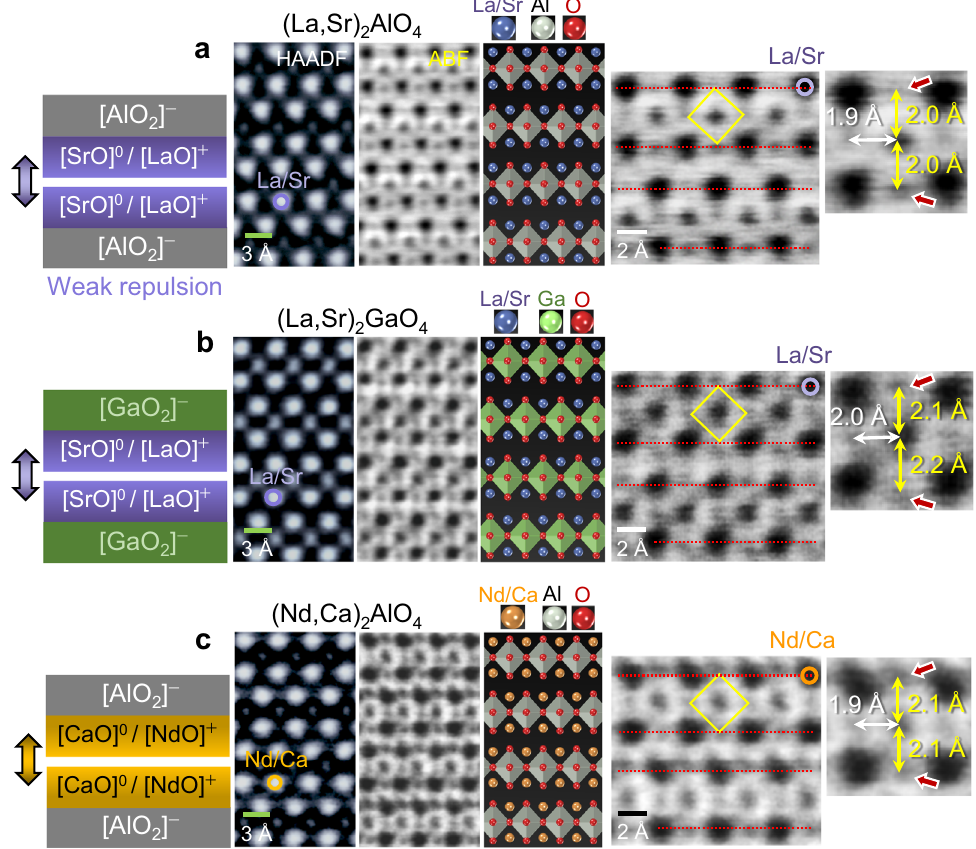
Fig. 8 STEM images showing the structure of (A ′ A ″ ) 2 BO 4 -type RP oxides. Atomic-column-resolved images were acquired in a (La,Sr) 2 AlO 4 , b (La,Sr) 2 GaO 4 , and c (Nd,Ca) 2 AlO 4 . Note that the A-site sublayers include [SrO] 0 (or [CaO] 0 ) with no effective charge and subsequently the electrostatic repulsion between the layers diminishes. Therefore, the elongation of the Al – O and Ga – O bonds toward the shear planes is not remarkable, showing a bond length of ≤ 2.2 Å. Magni fi ed ABF images directly provide quantitative information on the bond lengths. Red arrows in each image indicate a slight displacement of oxygen